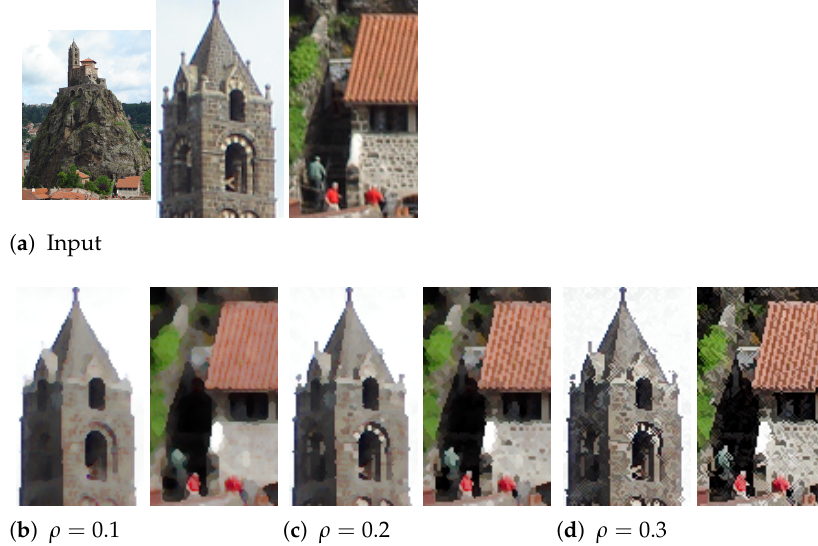
Figure 4. Impact of ρ parameter on smoothed morphological operators, with two zoomed parts of the